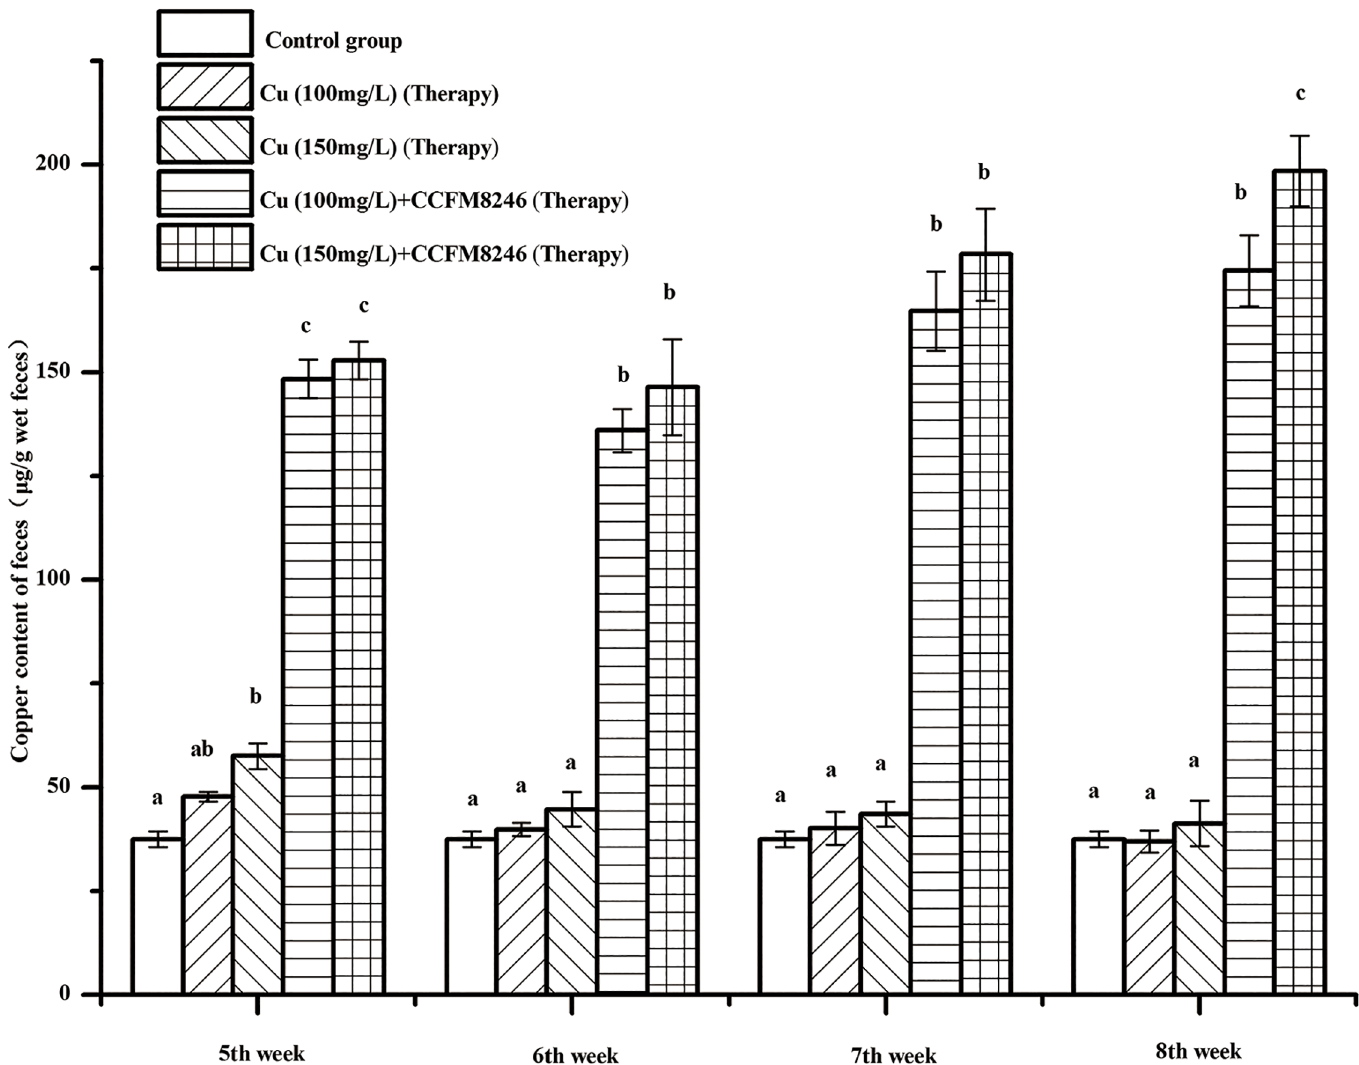
Fig 6. Copper content in wet feces of mice in therapy groups. Values are mean ± SEM with 10 mice in each group. The letters a, b and c mean that in each period, groups with different letters differ significantly ( p <